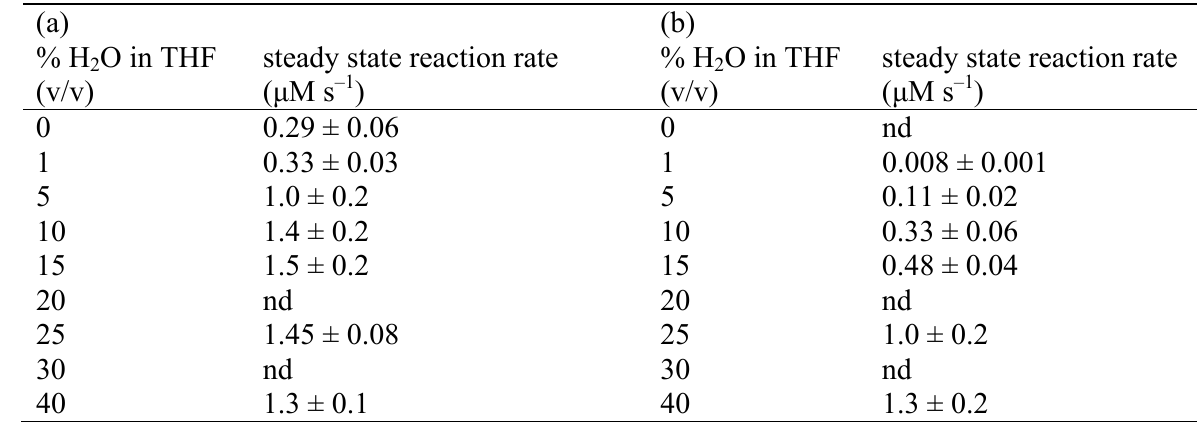
Table 2. Mean steady state reaction rates of 7 mol % Eu(OTf) (b) catalyzed Mukaiyama aldol reactions. Error represents standard error of the mean of 3 independent